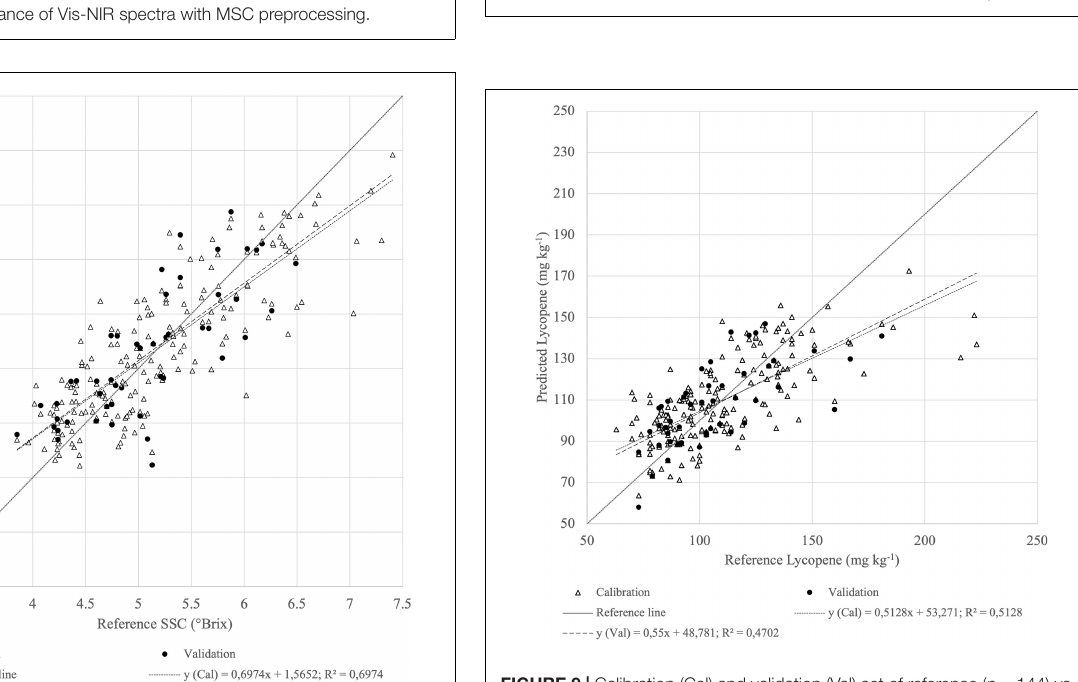
FIGURE 9 | Calibration (Cal) and validation (Val) set of reference ( n = 144) vs. predicted ( n = 48) lycopene content of homogenized tomato fruit samples derived from the best PLSR model from absorbance of SWIR spectra with first derivative